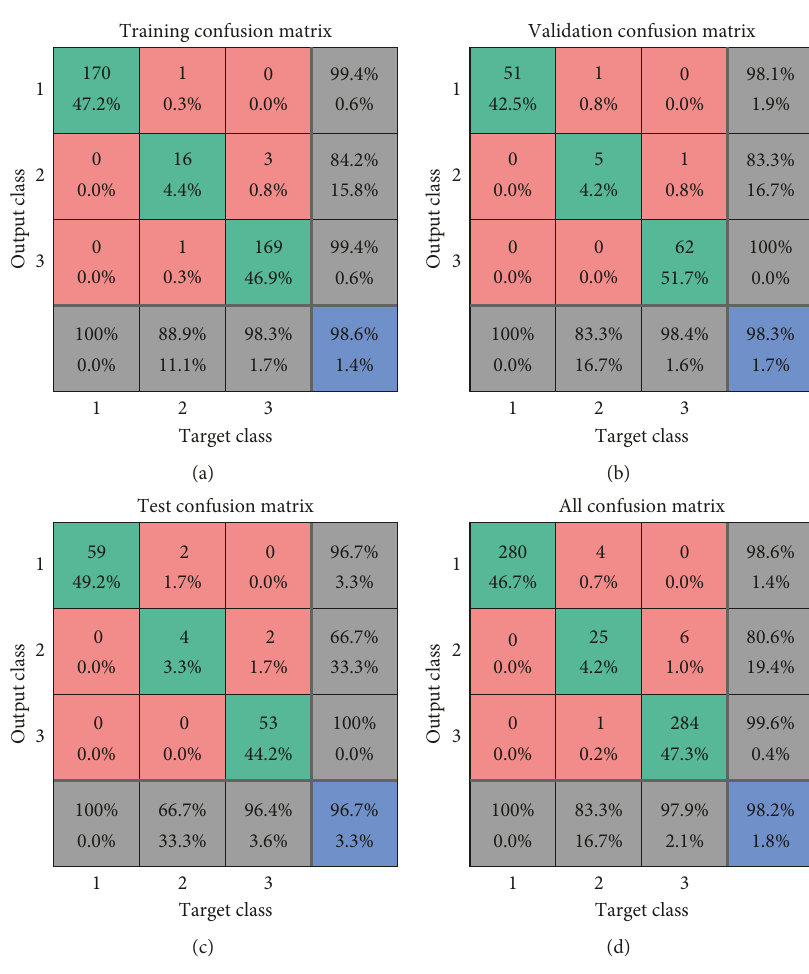
Figure 11: Cavitation identification result based on WPD-PCA-RBF.